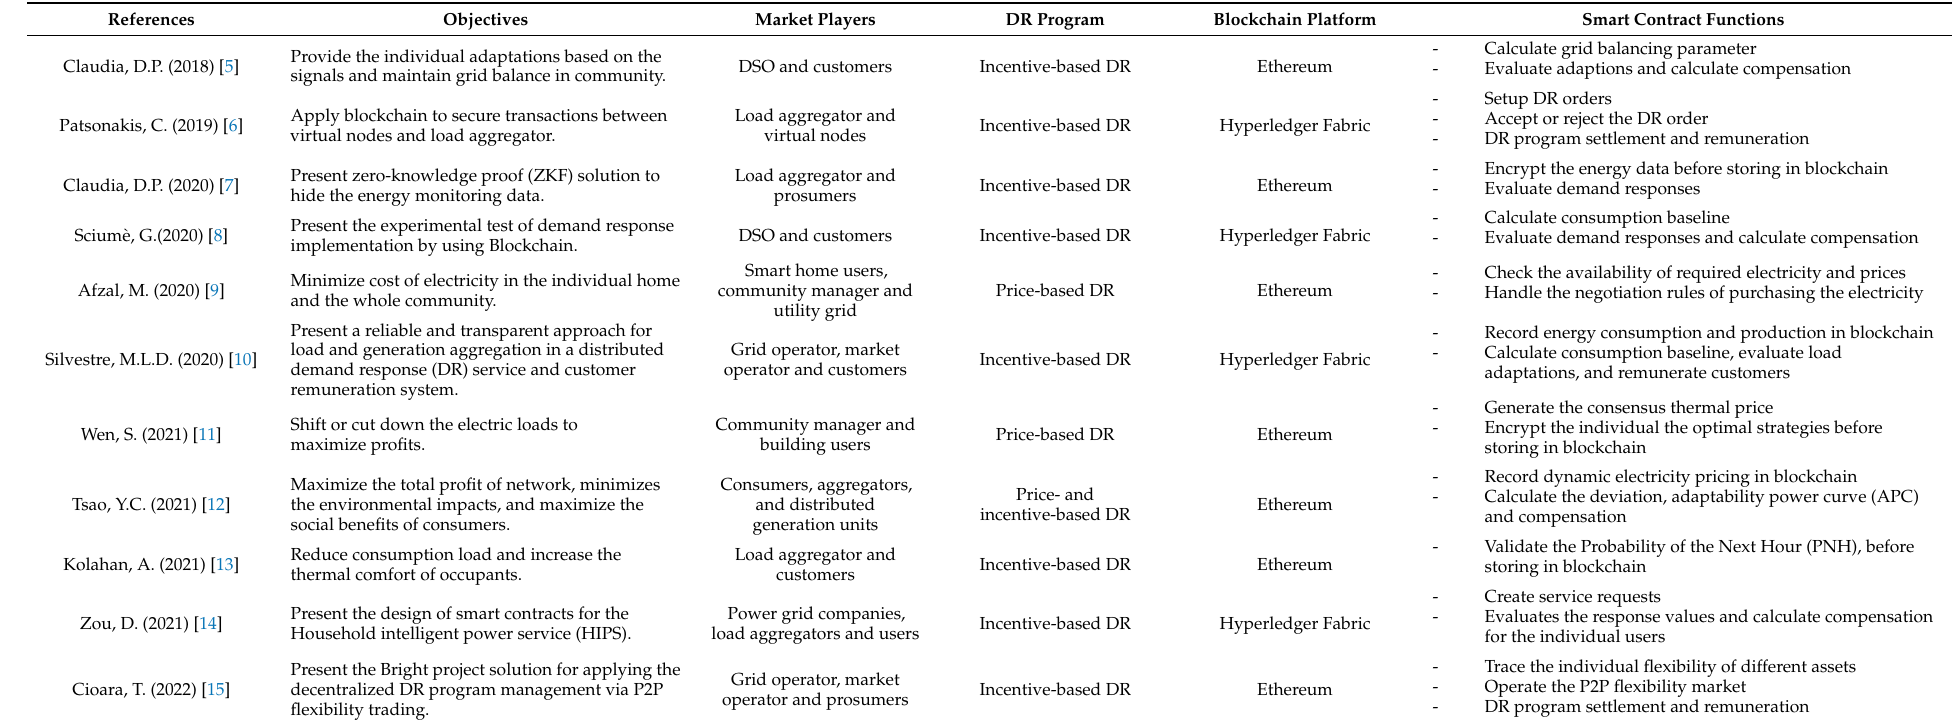
Table 2. A review of blockchain-based demand response